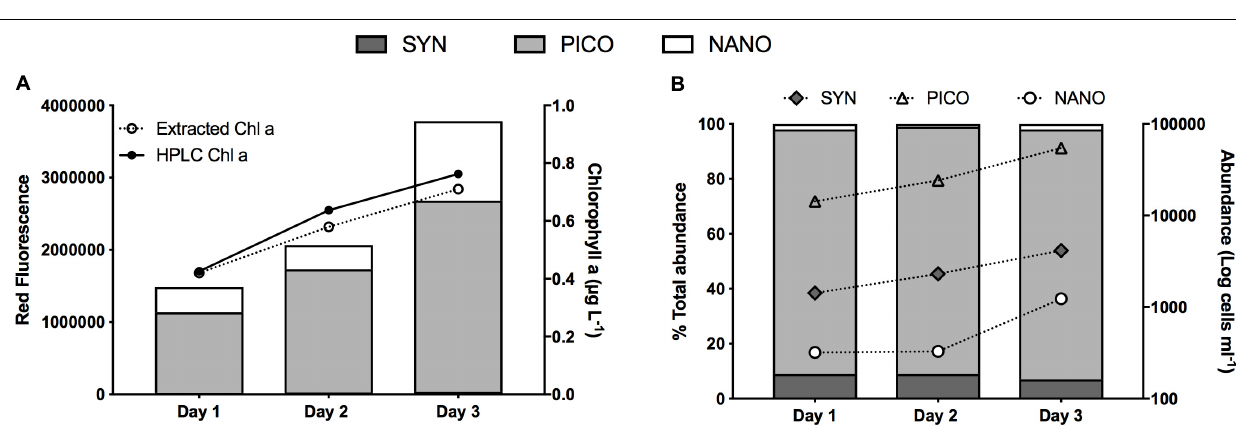
FIGURE 2 | Characterization of the phytoplankton community during the occupation of station 4 during NAAMES II: (A) Contribution to total red fluorescence (stacked columns, left y -axis) by each of three phytoplankton populations distinguished by flow-cytometry (SYN, Synechococcus ; PICO, Picoeukarytoes; NANO, Nanoeukaryotes), and chlorophyll a (line plots, right y -axis) from both pigment extraction and HPLC analysis. (B) Phytoplankton abundance per group (line plots, right y -axis) and contribution (%) of each group to total abundance (stacked columns, left y